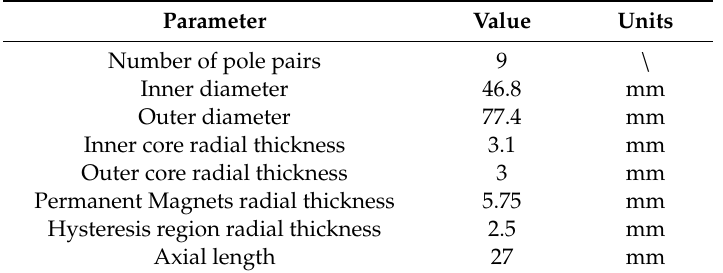
Figure 7. Hysteresis Clutch.